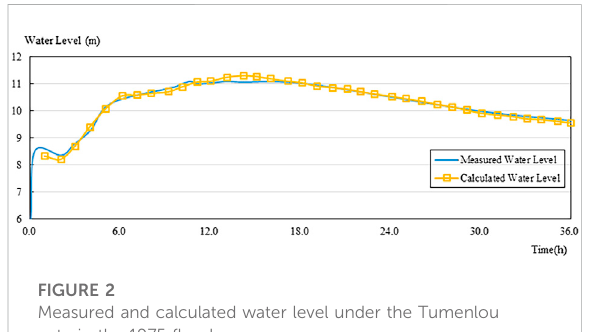
FIGURE 2 Measured and calculated water level under the Tumenlou gate in the 1975 fl ood.